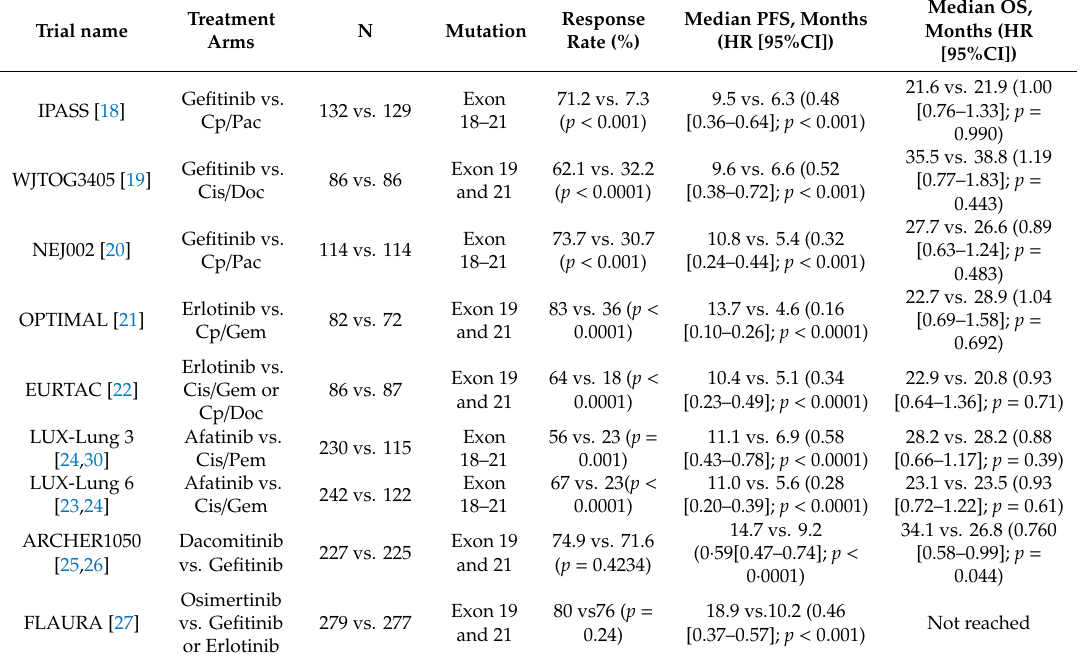
Table 1. Summary of trials of first-line therapy using three generations of Epidermal Growth Factor Receptor (EGFR)-tyrosine kinase inhibitors (TKIs) in patients with mutation-positive non-small cell lung cancer (NSCLC).